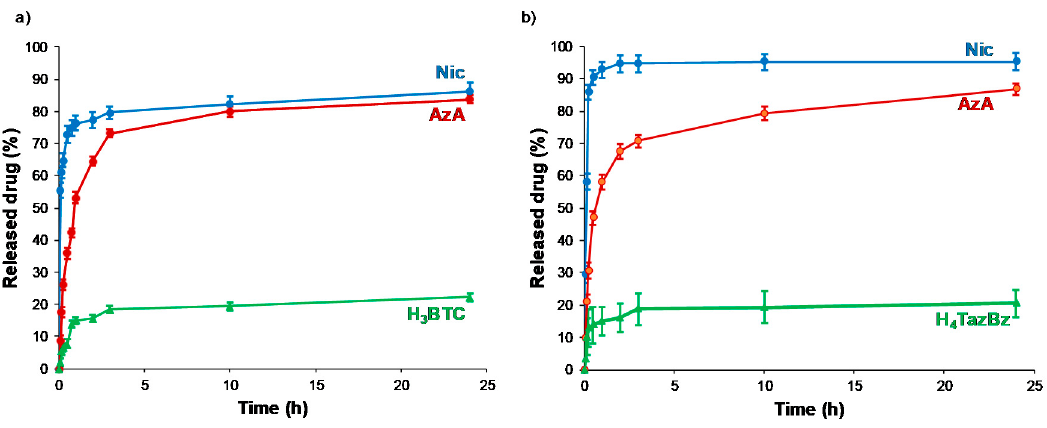
Figure 4. Nic and AzA co-release from ( a ) MIL-100 and ( b ) MIL-127. The leached (H 3 BTC and H 4 TazBz) ligands were also represented. ligands were also